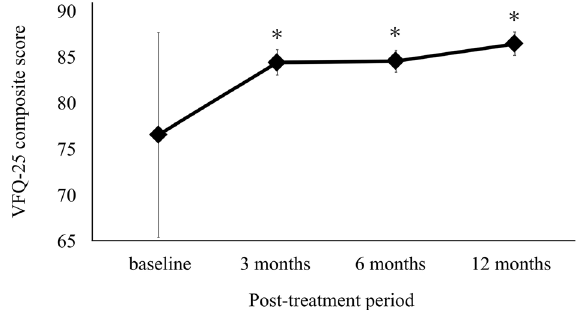
Figure 1. Time course of changes in the 25-item National Eye Institute Visual Function Questionnaire (VFQ- 25) composite score in patients with branch retinal vein occlusion (BRVO). The VFQ-25 composite score improved significantly from 3 months after treatment (* P < 0.05; One-way repeated analysis of variance with Dunnett’s test).